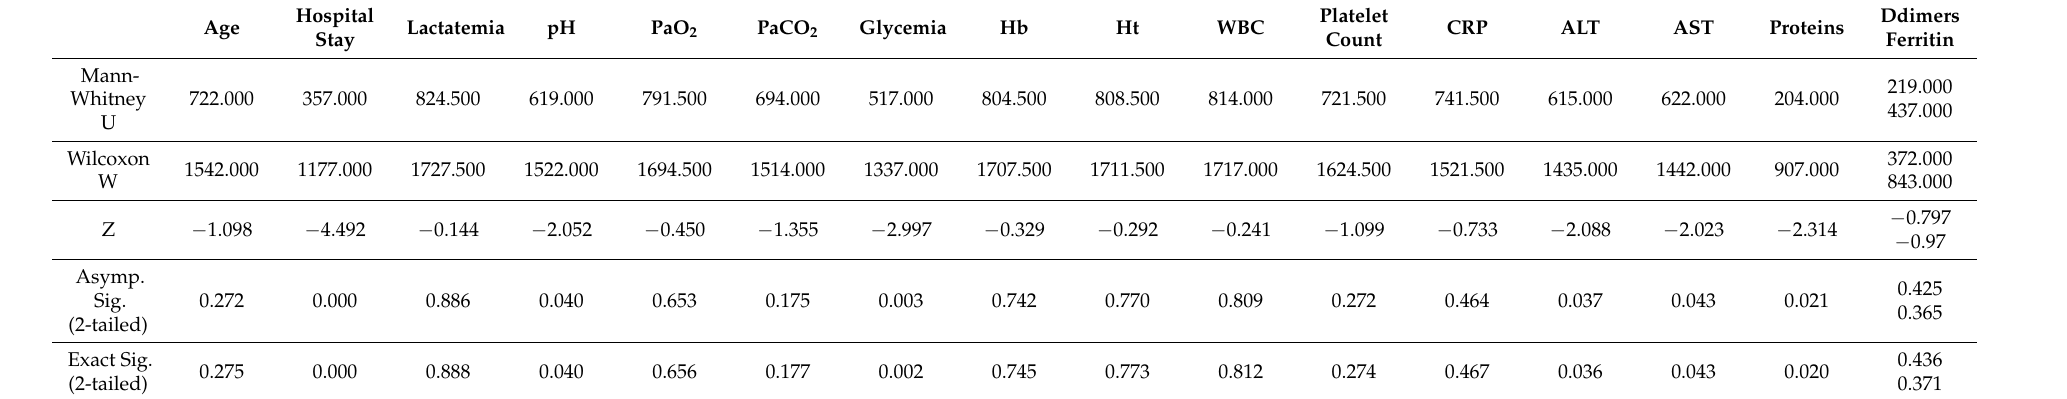
Table 2. Comparation between the Age, Lenght of hospitalization and biochemical values at admission depending on the severity form of disease Test